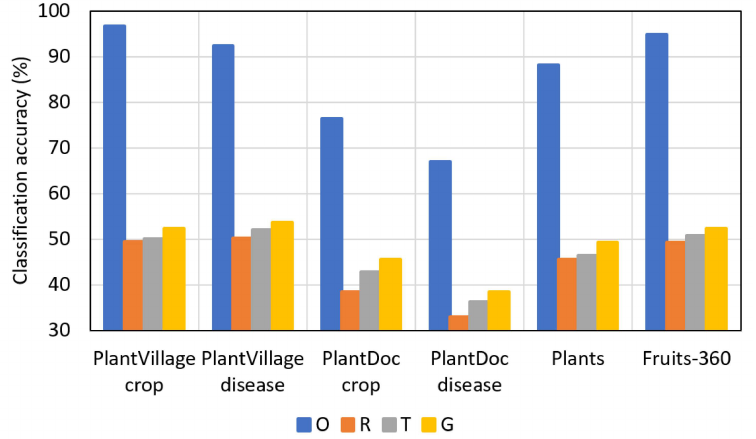
Figure 13. Comparison of F1-scores based on all the datasets (original dataset (O), reduced dataset (R), dataset augmented by conventional method (T), and dataset augmented by PI-GAN (G)). The datasets have been reduced to 30%.